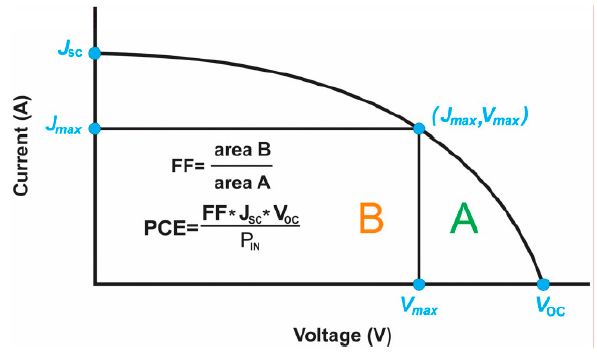
Figure 1. Current-voltage characteristics for solar cells, [35].